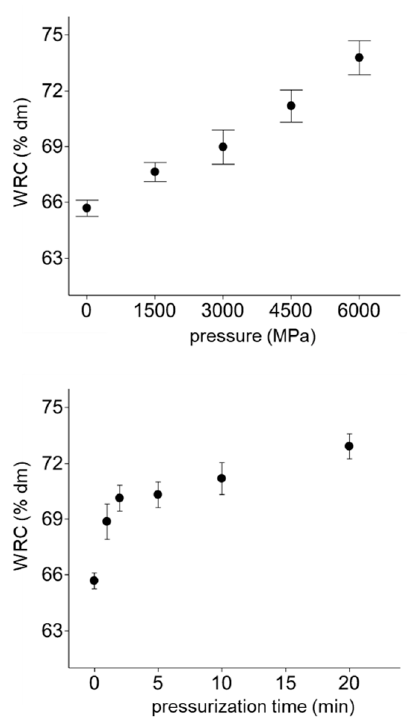
Figure 2. Impact of pressure and pressurization time on hydration properties (WRC = water retention capacity) of wheat flour, (cid:1876)̅ ± SD, n = 3